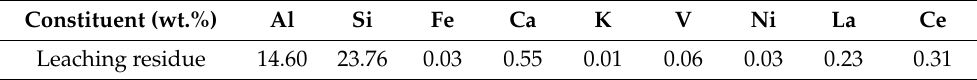
Table 2. Chemical composition of leaching residue obtained using optimum conditions. Constituent (wt.%)